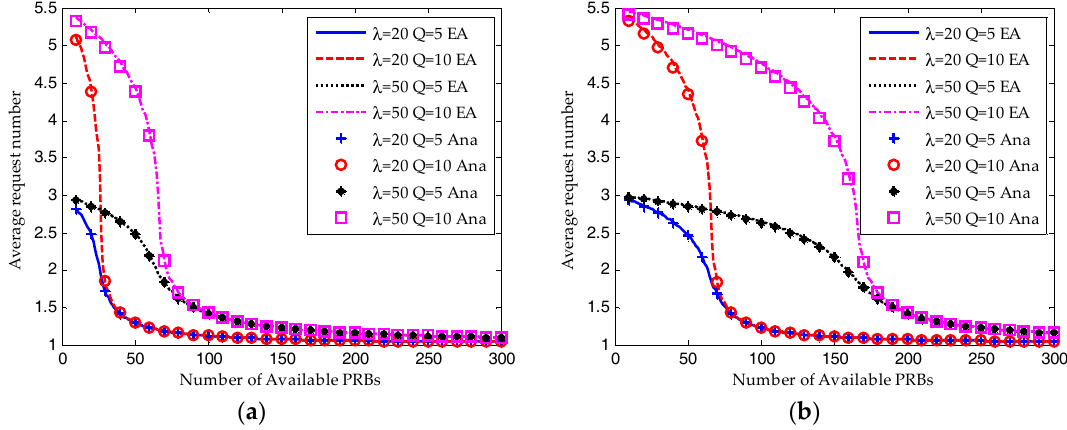
Figure 9. Comparison of request number between equilibrium analysis and iterative analytical results (W BO = 0): ( a ) S-ALOHA protocol; ( b ) TDMA protocol.